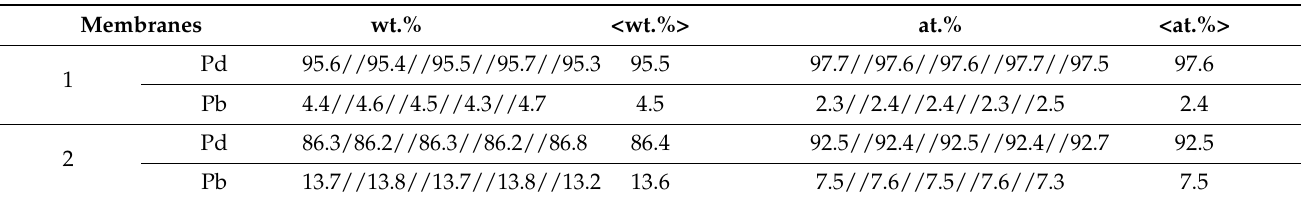
Figure 4. Results of element analysis of Pd/Pb membranes. ( a )—Typical EDXS spectrums of mem- branes; SEM images of the surface ( b )—membrane 1 ; ( c )—membrane 2 . The white frames indicate areas of EDXS analysis. Table 1. The EDXS analysis results of the composition of membrane filters. Membranes